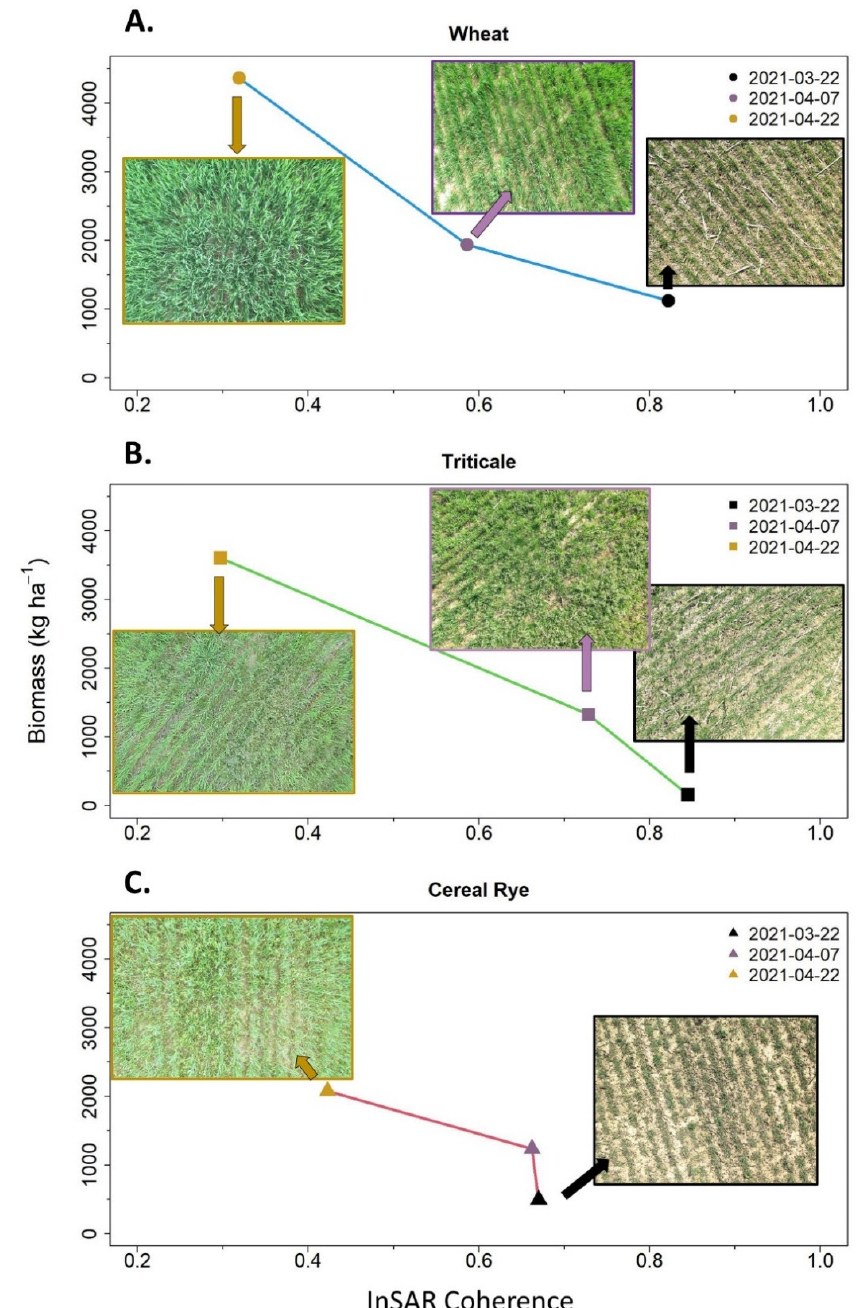
Figure 6. Examples of wheat ( A ), triticale ( B ), and cereal rye ( C ), biomass plotted against InSAR coherence. Lower InSAR coherence values are indicative of general changes in field conditions between two images forming an InSAR pair as well as general shifts from coherent surface scattering to incoherent random scattering as cover crops mature comparing different InSAR pairs. For the biomass sampling dates (included in the upper right of each panel) the following InSAR pairs were matched: (1) 3-14-21 and 3-26-21, (2) 3-26-21 and 4-19-21, and (3) 4-19-21 and 5-1-21. For